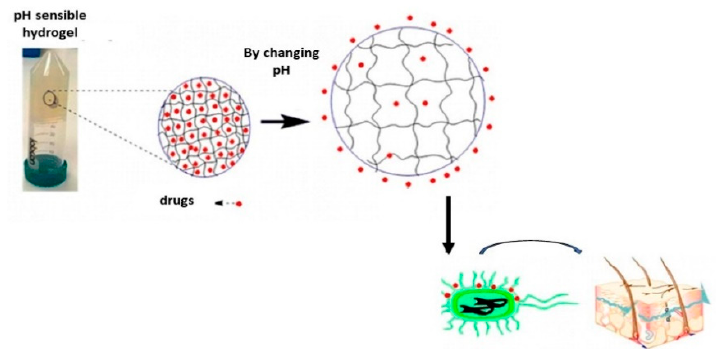
Figure 3. Schematic illustration of hydrogel for antibacterial and wound healing applications.